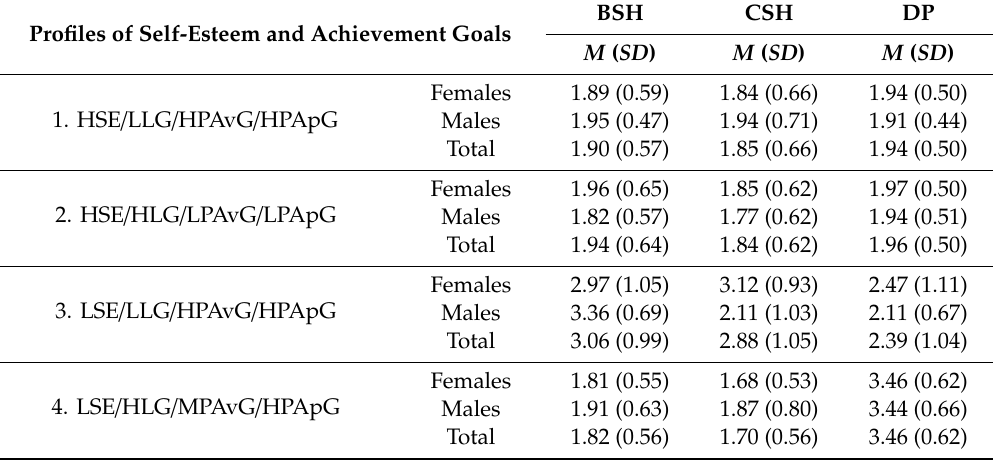
Table 5. Descriptive statistics (means and standard deviations) corresponding to profiles of self-esteem and achievement goals in self-handicapping and defensive